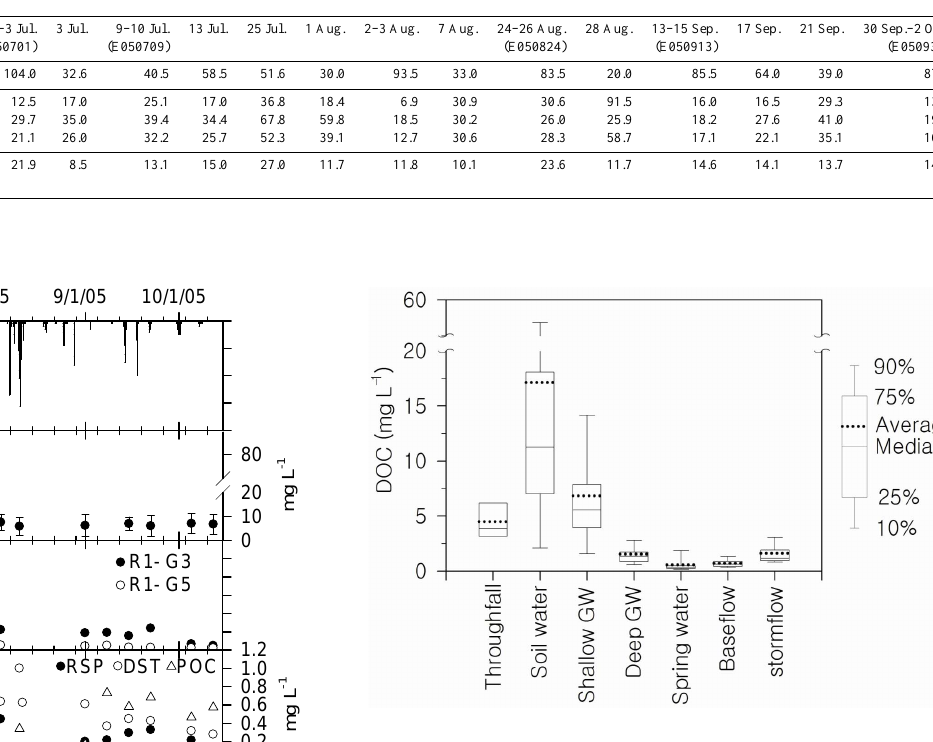
Fig. 5. The concentrations of DOC from throughfall, soil water, shallow groundwater (0.5 m), deep groundwater (0.8–1.0 m), spring water, and baseflow, and stormflow for the period from April to October 2005.